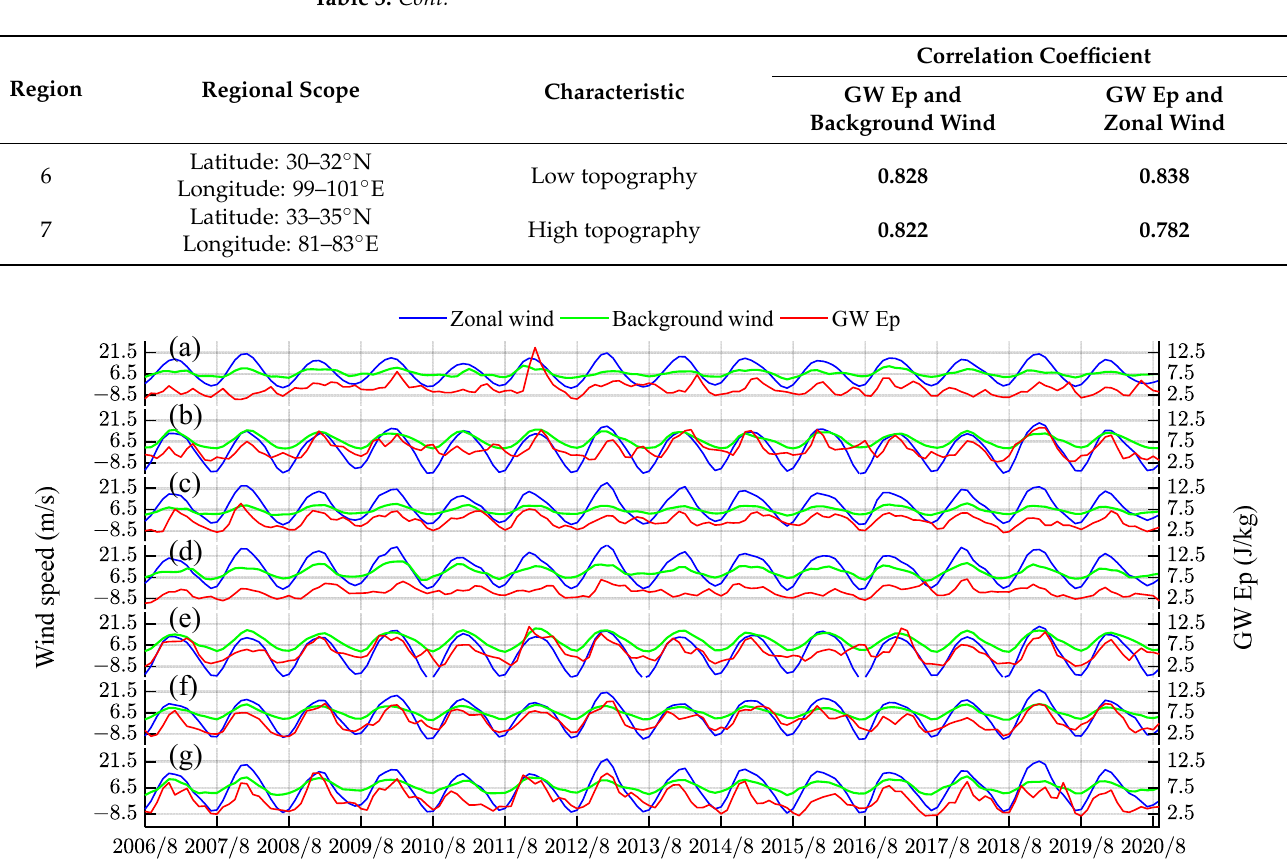
Figure 11. The relationship between the GW Ep over different regions depicted in Table 3 with the background wind and the zonal wind from August 2006 to September 2020. ( a ) Region #1; ( b ) Region #2; ( c ) Region #3; ( d ) Region #4; ( e ) Region #5; ( f ) Region #6; ( g ) Region #7. The background wind is the average over the elevation range of each region. Blue solid line, zonal wind; green solid line, background wind; red solid line, GW Ep.